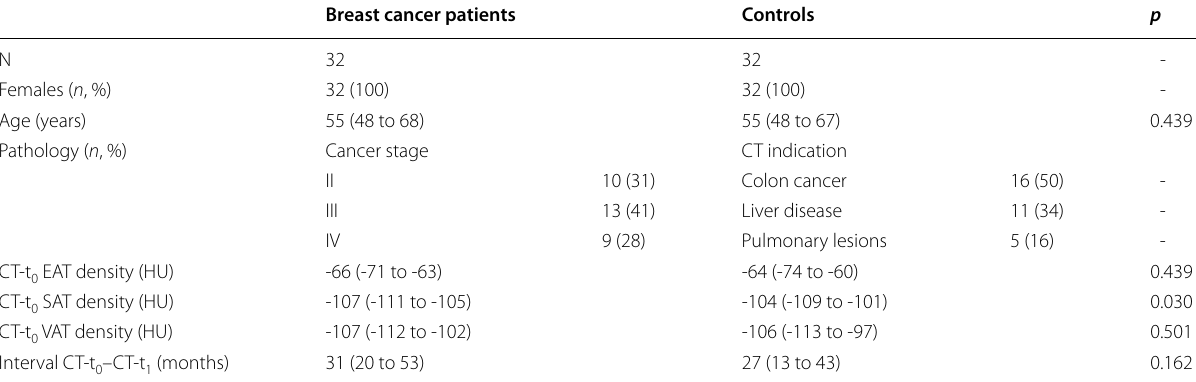
Table 1 Demographical and adipose tissue data for breast cancer (BC) patients undergoing treatment with anthracyclines and